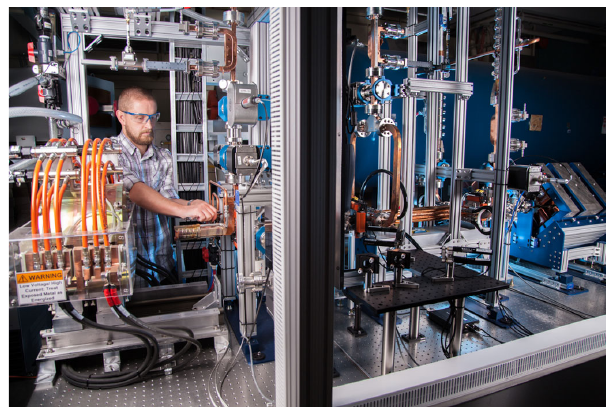
FIG. 5. Photograph of compact high gradient accelerator capable of 100 MeV in a few